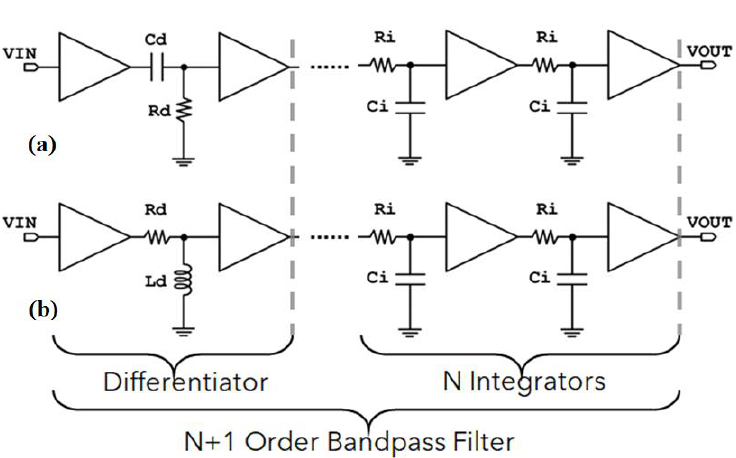
Figure 5. (n + 1)th order bandpass filter ( a ) CR high-pass filter implementation, ( b ) RL high-pass filter implementation.